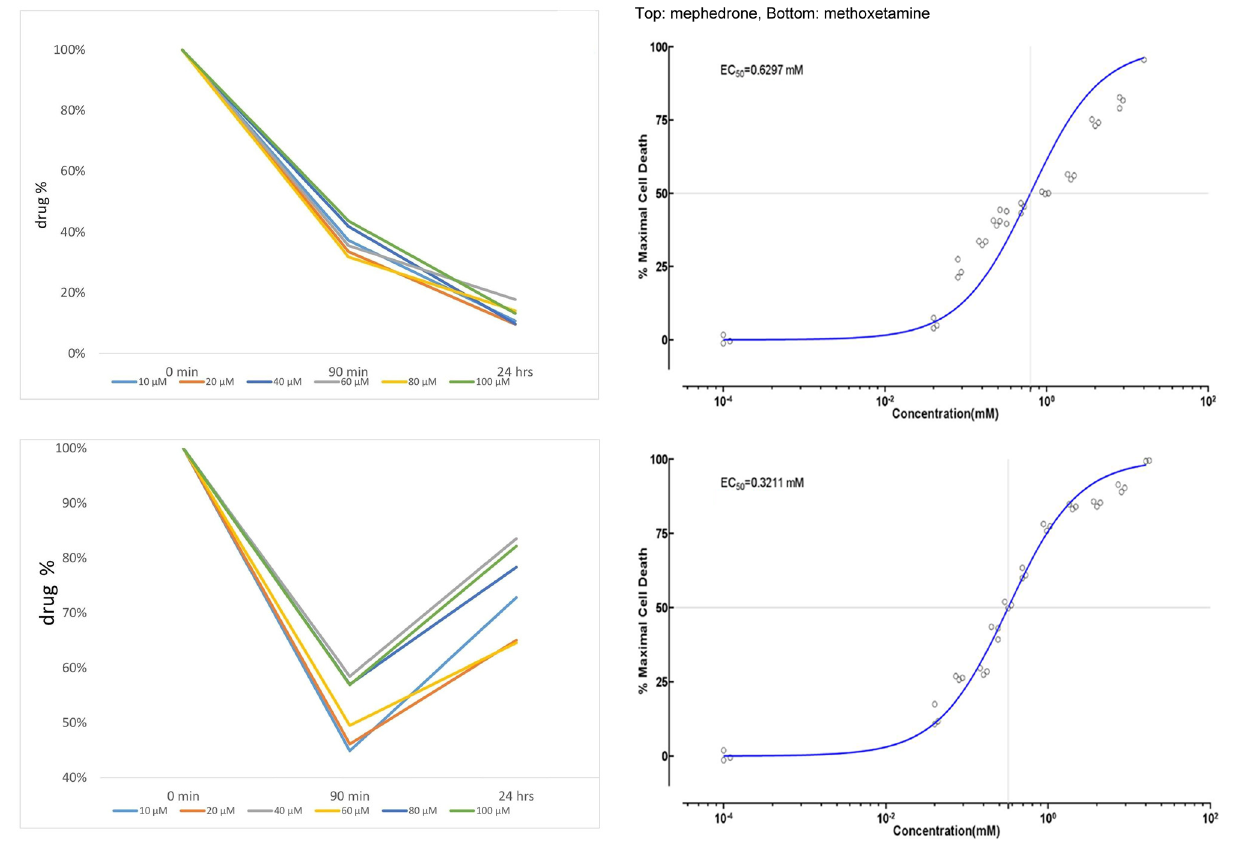
Figure 7: Normalized cell death percentage of HepaRG cells induced by selected NPS 48 h after incubation under speci fi ed conditions. Top: mephedrone. Bottom: